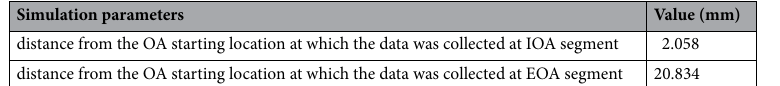
Simulation parameters